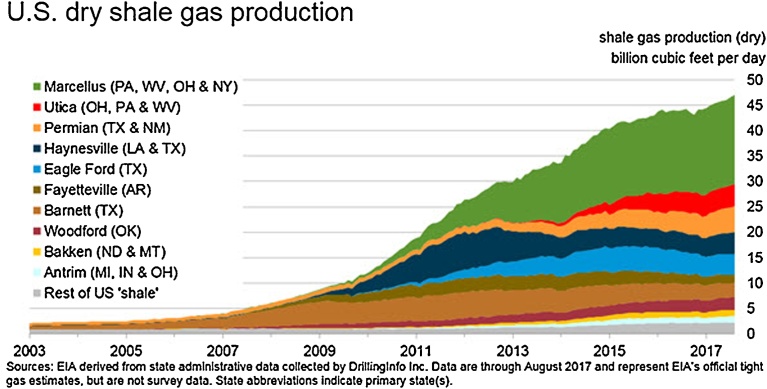
The production of shale gas in the US. Source: EIA (2016).